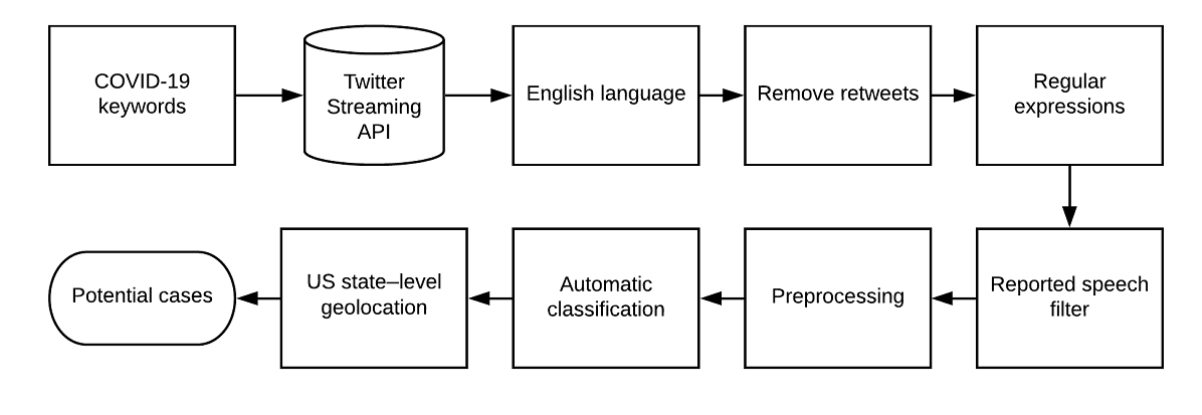
Figure 1. Automatic natural language processing (NLP) pipeline for detecting tweets that self-report potential cases of COVID-19 in the United